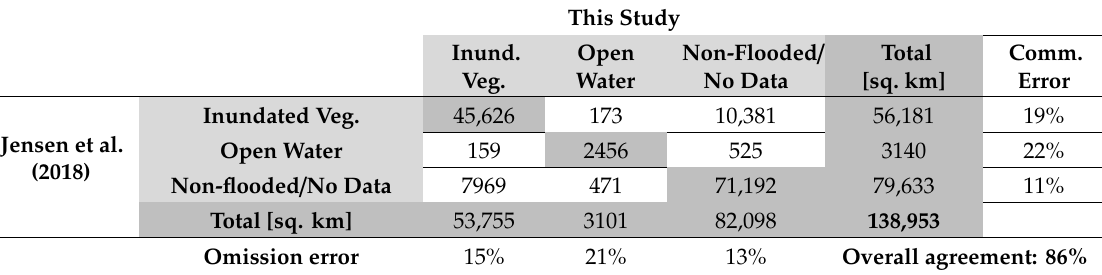
Table 3. Confusion matrix of the two decision tree classifications over Pacaya-Samiria National Reserve by Jensen et al. (2018) and this study. Values are in km 2 . This Study Inund. Open Non-Flooded / Total Comm. Veg. Water No Data [sq. km] Error Inundated Veg. 45,626 173 10,381 56,181 19% Jensen et al. Open Water 159 2456 525 3140 22% (2018) Non-flooded / No Data 7969 471 71,192 79,633 11% Total [sq. km] 53,755 3101 82,098 138,953 Omission error 15% 21% 13% Overall agreement: